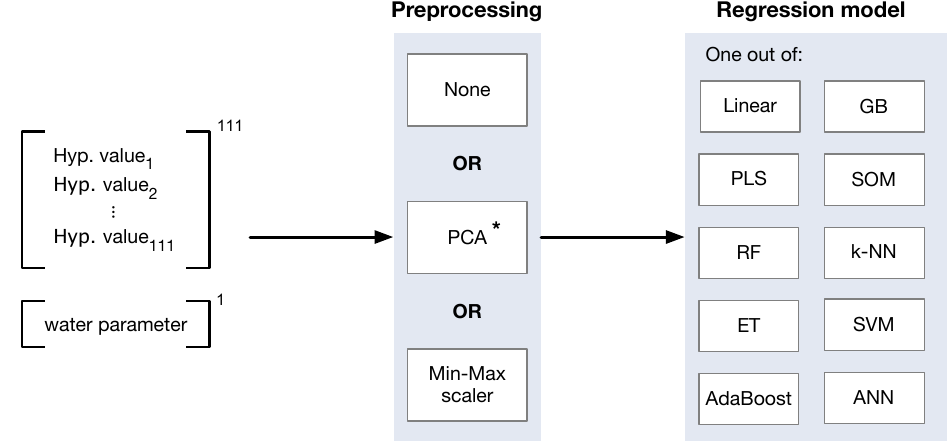
Figure 4. Schematic representation of the regression framework (adapted from [23]). The water quality parameter is either CDOM, chlorophyll a , green algae, diatoms or turbidity. * PCA is applied solely on the hyperspectral vector